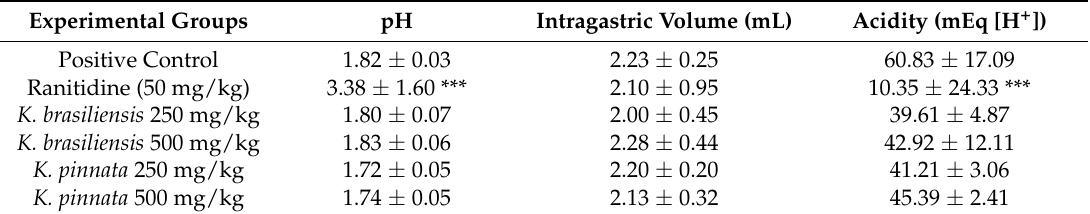
Table 5. Effect of pre-treatment with K. brasiliensis and K. pinnata leaf juices (250 and 500 mg/kg) on pH, total acidity and intragastric volume using the pylorus ligation